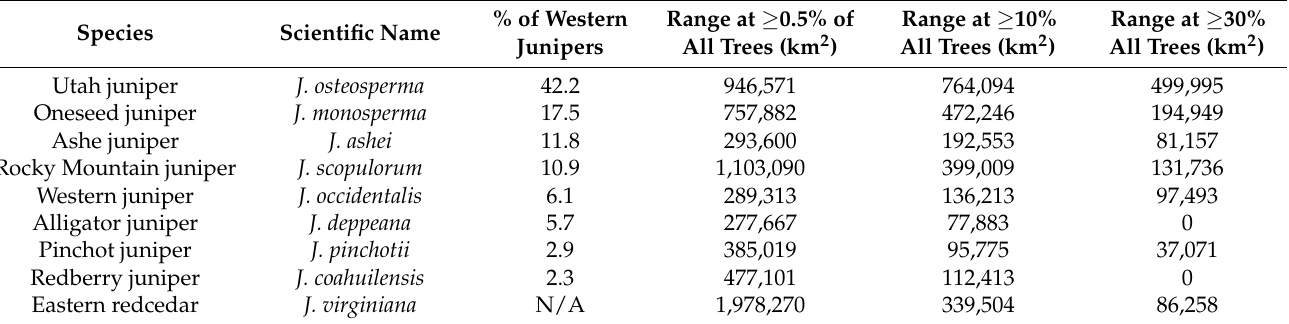
Table 1. Summary statistics of Juniperus species for recent surveys, not limited by areas with older surveys. Percent values are percent of total